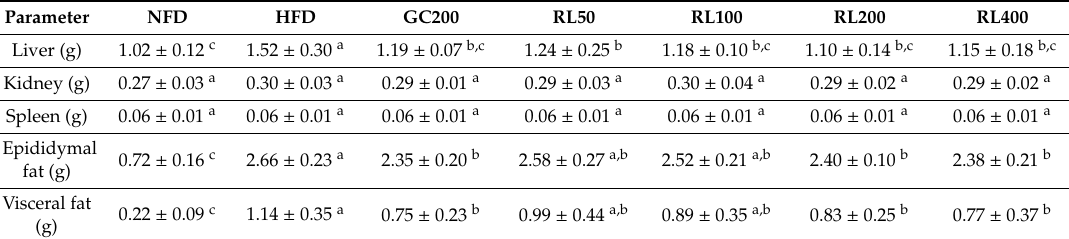
Table 3. E ff ects of RL at various concentrations on organ wet weight in high-fat diet-induced obese C57BL / 6J